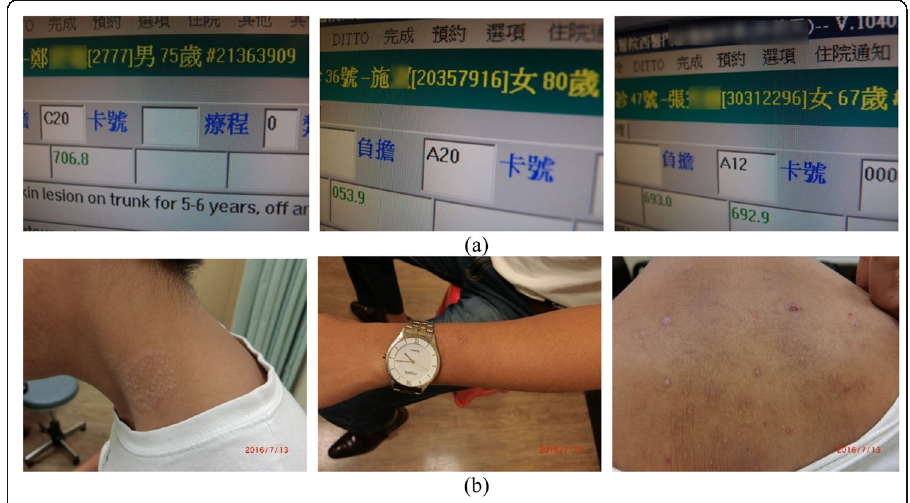
Fig. 1 Examples of camera-captured images: a screen and b